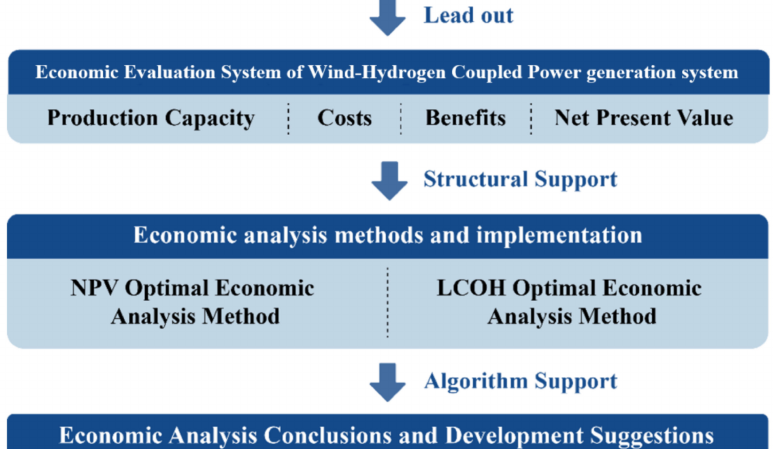
Figure 2. Flowchart of the proposed study